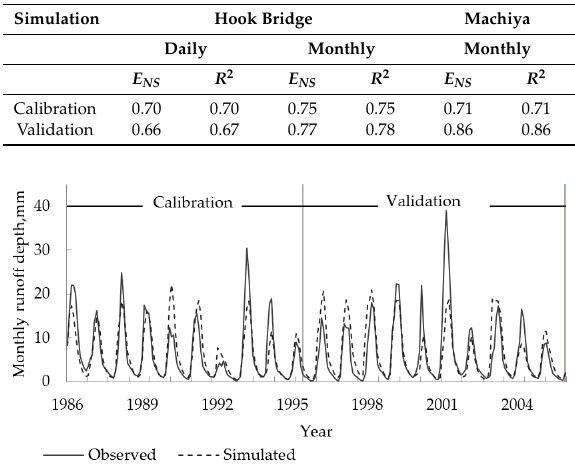
Figure 3. Observed and Simulated runoff during 1986–2005 for Hook Bridge hydrological station.